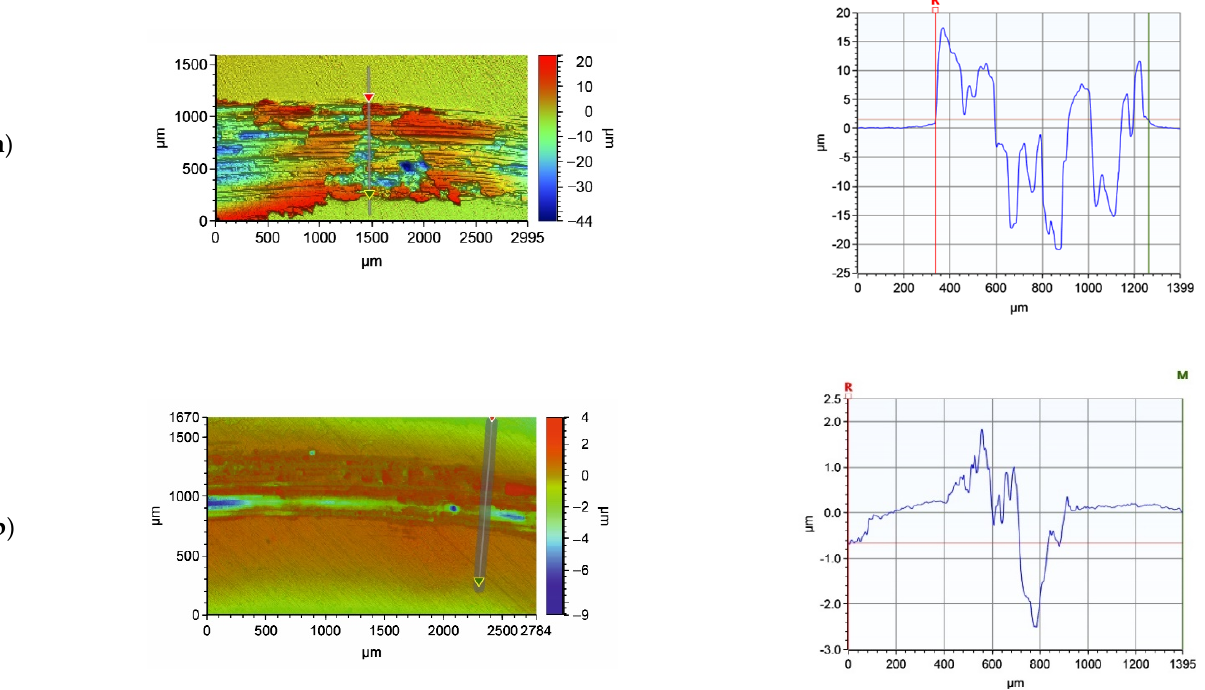
Figure 17. Representative 2D profiles of the wear track for ( a ) copper and ( b ) copper after laser alloying (Cr50WC50).